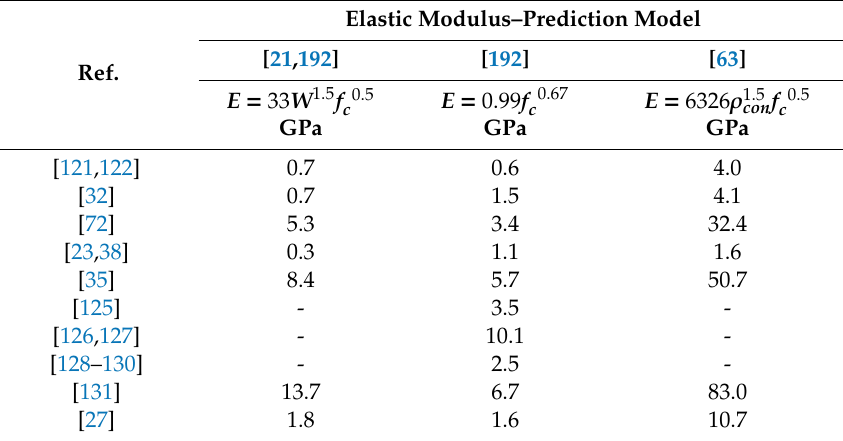
Table 8. Prediction models of di ff erent